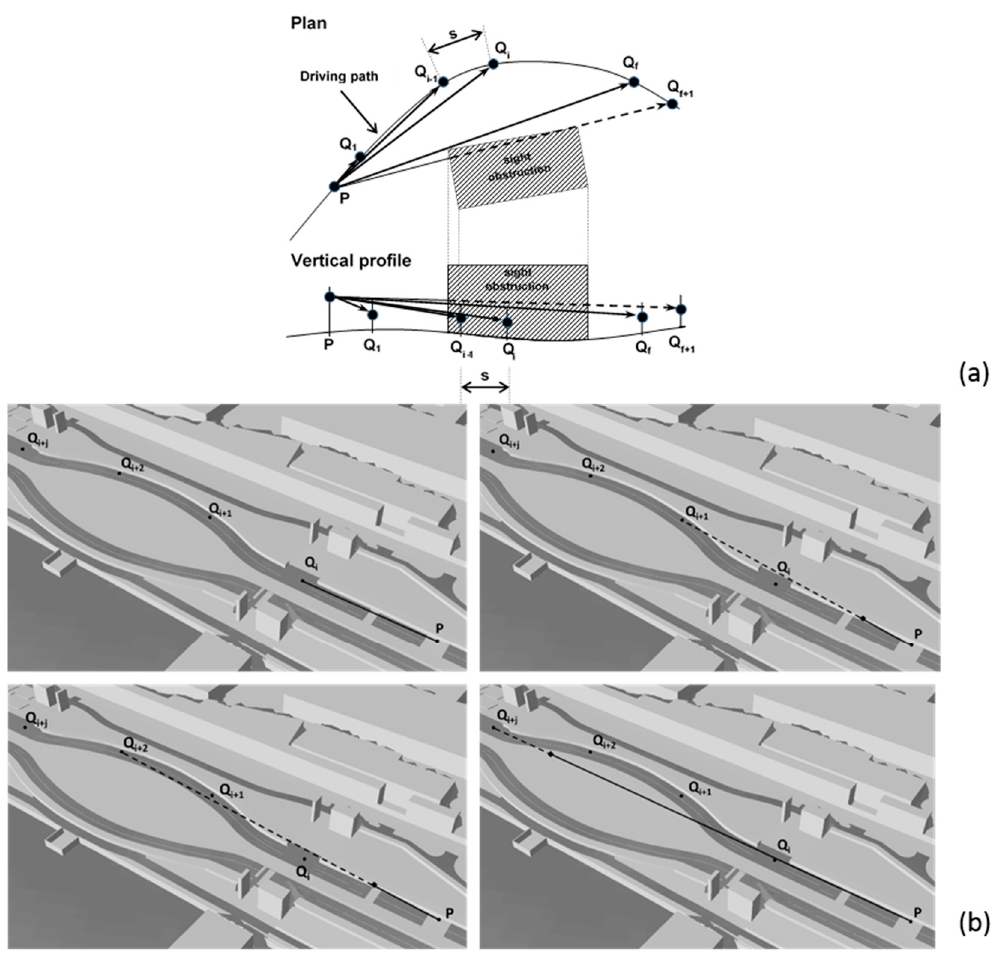
Figure 7. ( a ) Horizontal and vertical 2D and ( b ) 3D representation of the algorithm used for estimating the ASD (the continuous line represents the visible part of the line of sight, while the dashed one is the portion blinded by the sight obstruction).